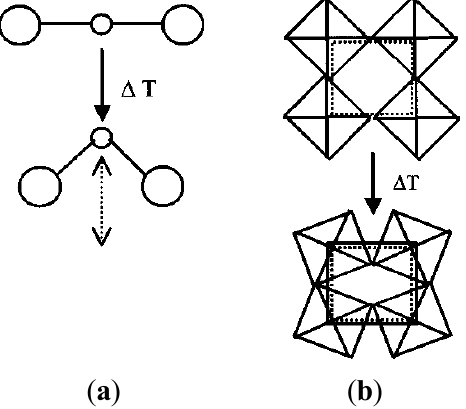
Figure 2. Schematics of vibrational modes leading to NTE: ( a ) Transverse vibrational motion of an oxygen atom in a M-O-M linkage causing a decrease of the metal-metal distance; ( b ) cooperative rocking of polyhedra causing a decrease in average metal-metal